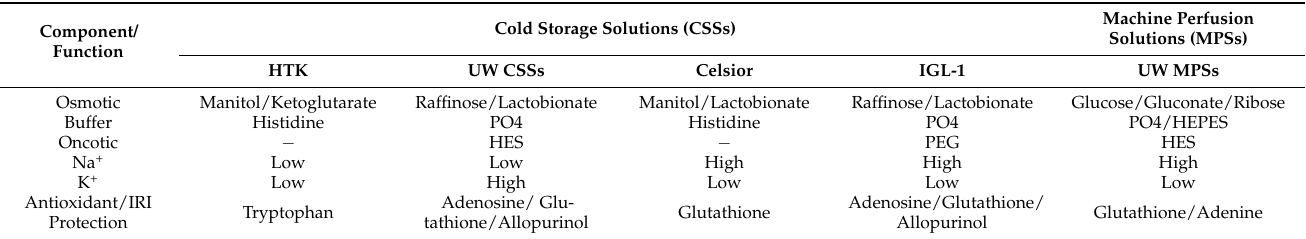
Table 1. Main components of cold storage solutions (CSSs) and machine perfusion solutions (MPSs). CSS: cold storage solution; HES: hydroxyethyl starch; HTK: histidine–tryptophan–ketoglutarate; IRI: ischemia/reperfusion injury; K + : potassium intracellular ion; MPS: University of Wisconsin (Belzer) machine perfusion solution; Na + : sodium extracellular ion; PEG: polyethylene glycol; UW: University of Wisconsin